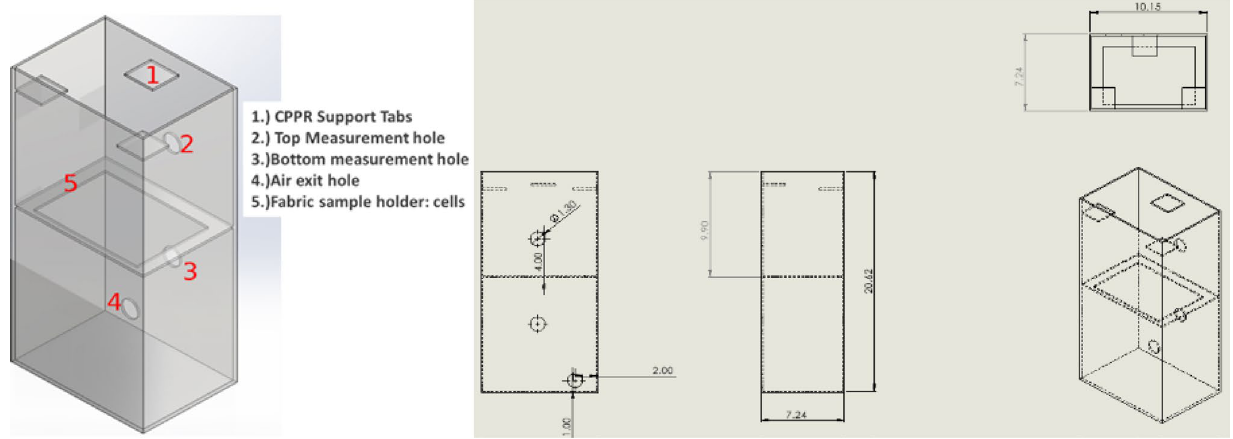
Figure 5. Schematic and dimensions of the enclosure built for ozone penetration tests.